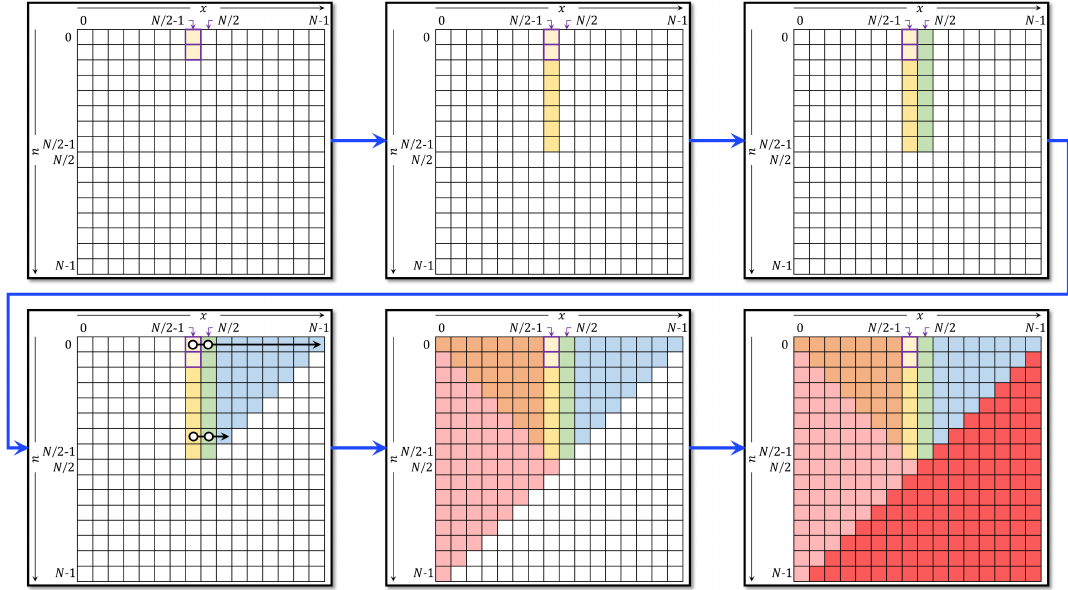
Figure 5. The steps used to compute DKPCs using the proposed recurrence